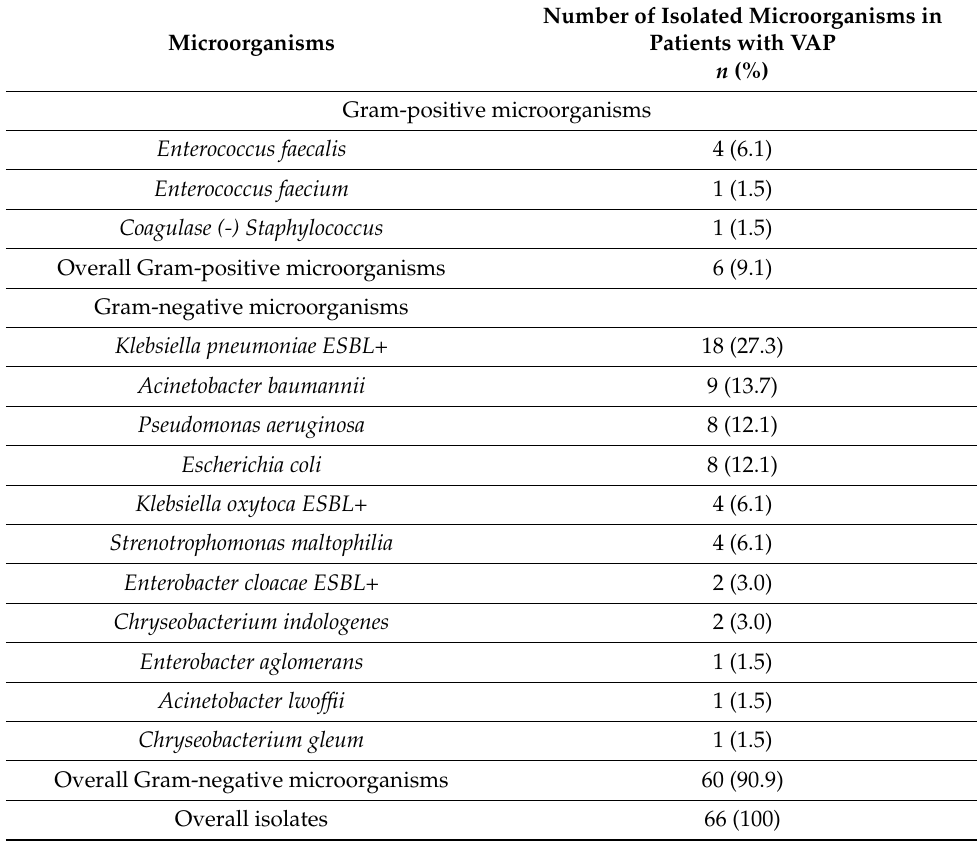
Table 2. Microorganisms isolated in patients with